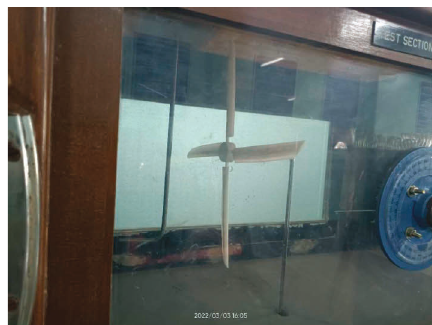
Figure 7: HH02 rotor model in the wind tunnel.